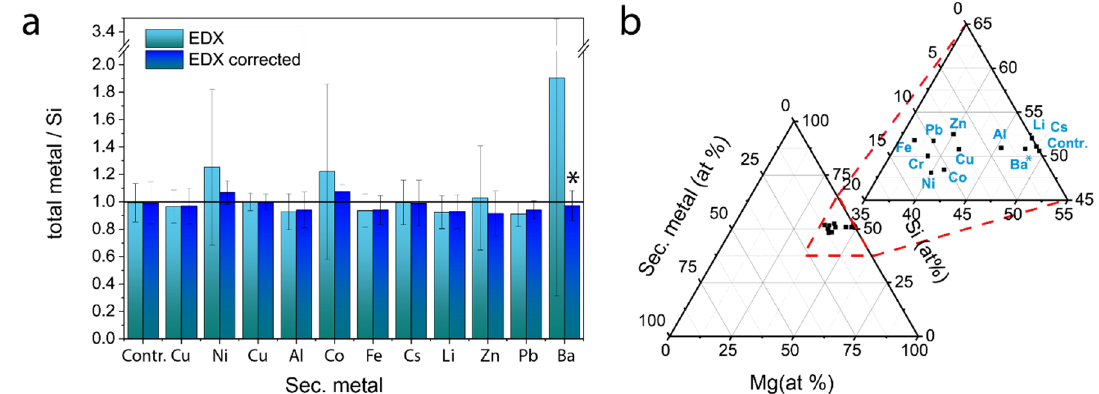
Figure 6. ( a ) Comparison of the total metal (Mg+ secondary metal) to Si ratio measured via energy-dispersive X-ray spectroscopy (EDX). ( b ) Ternary plot of the Mg-Si-secondary metal composition in atomic % for the precipitated samples measured with EDX. *: corrected total metal /Si ratio for M-S-H containing Ba neglecting the highest 20 values.